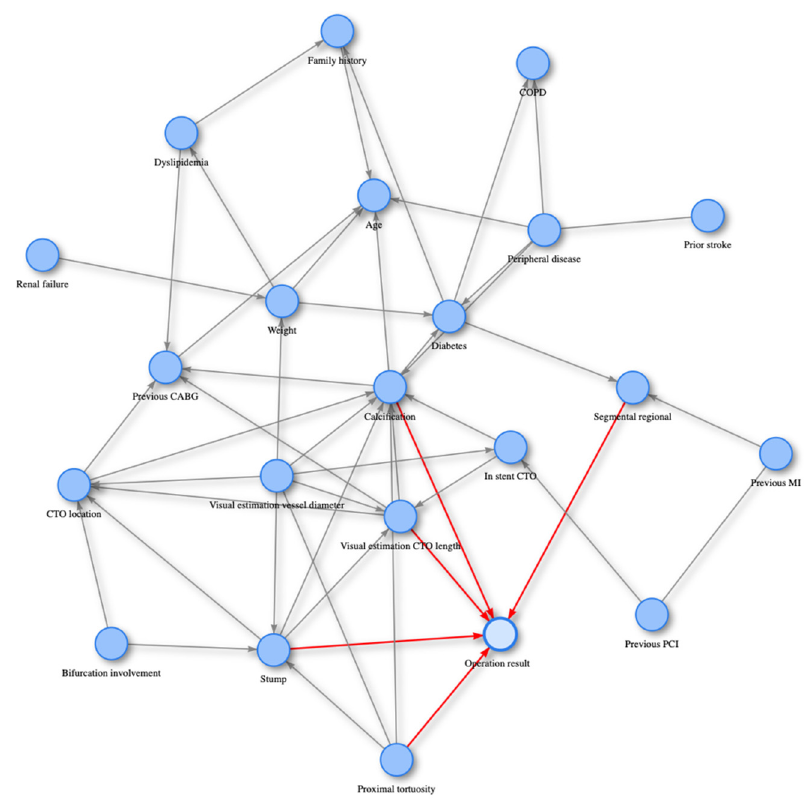
Figure 2. The causal graph over the downsampled training dataset ( n = 3026, 22 variables) is displayed. The five nodes/variables constituting the Markov blanket around the operation success exhibit a directed arrow towards operation success. Table 1. Multivariate binary logistic regression analysis for success of the PCI. Estimates of the odds ratios (Exp(B)) and their 95% confidence intervals corresponding to the MBFS model based on the downsampled training dataset ( n = 3026) are displayed, along with their p -values.